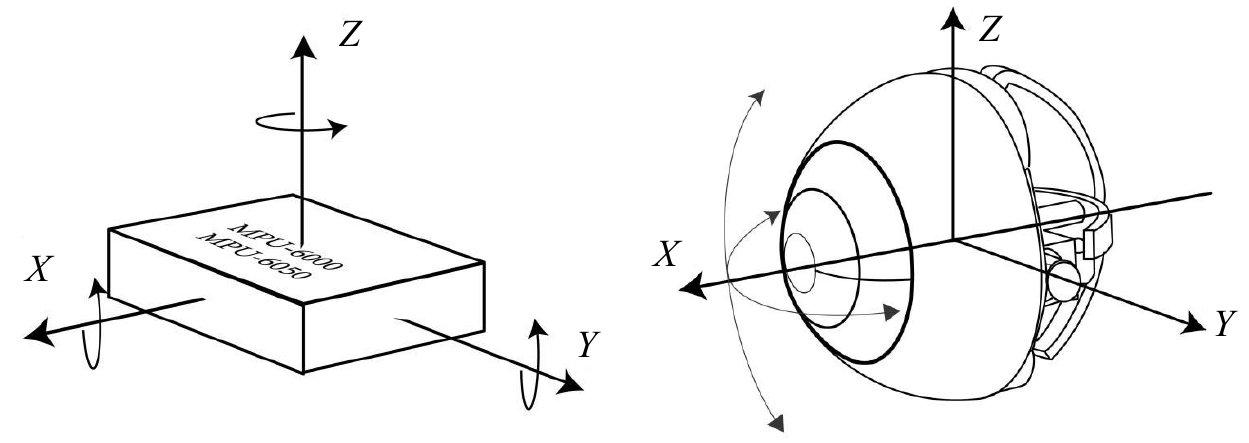
Figure 1. IMU and diagram of the way the bionic eye rotates.